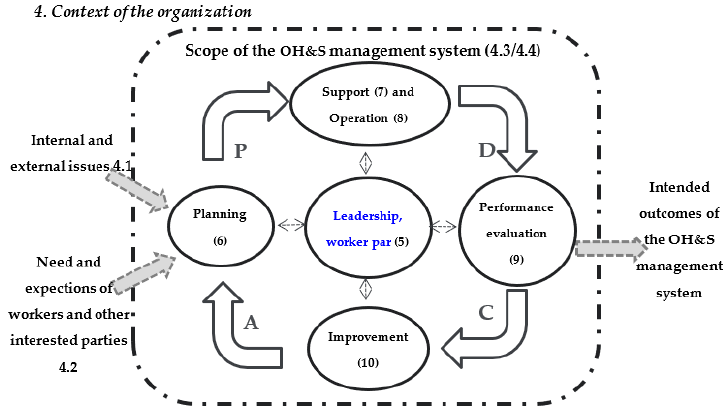
Figure 2. Health and safety management system vs. PDCA [2].